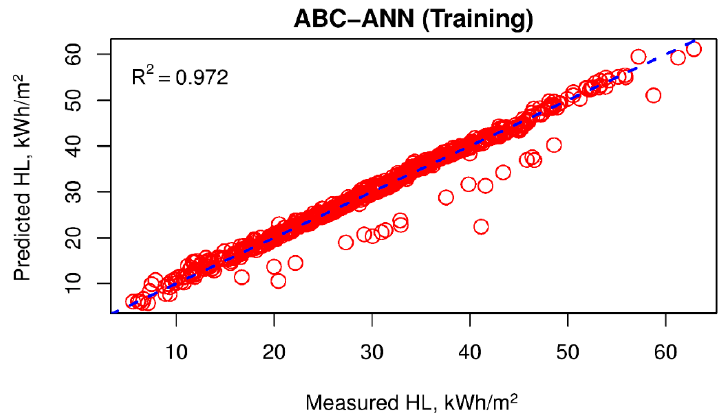
Figure 20. HL predictions on the training dataset of the ABC-ANN model.